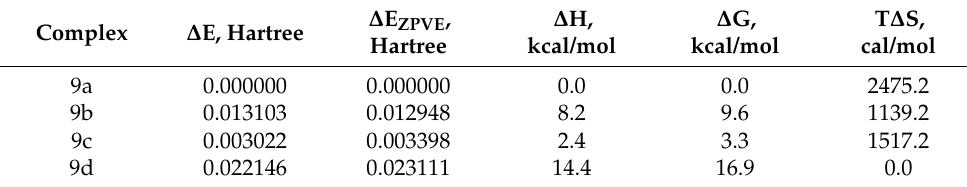
Table 4. Relative thermodynamic parameters of isomeric complexes 9. Complex